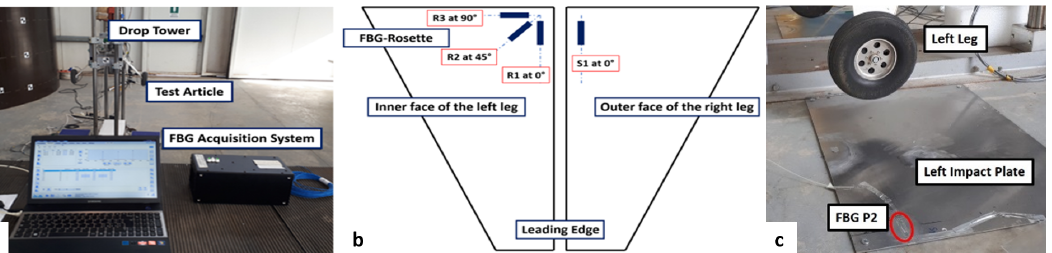
Figure 3. ( a ) Test set-up; ( b ) Array 1 (inner face of the left leg with three FBGs in rosette configuration) and Array 2 (outer face of the right leg with a single FBG aligned with the 0° direction) configurations ( c ) FBG P2 on the left impact plate . Table 1. Grating arrays characteristics.